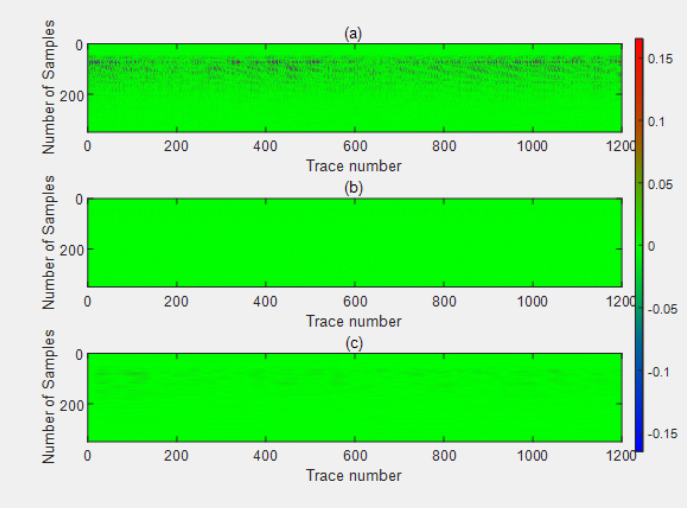
Figure 12. The comparison results of rotor interference test ( a ) with rotors and the motors working and ( b ) without rotors but the motor working ( c ) under the case of ( a ) by LDF